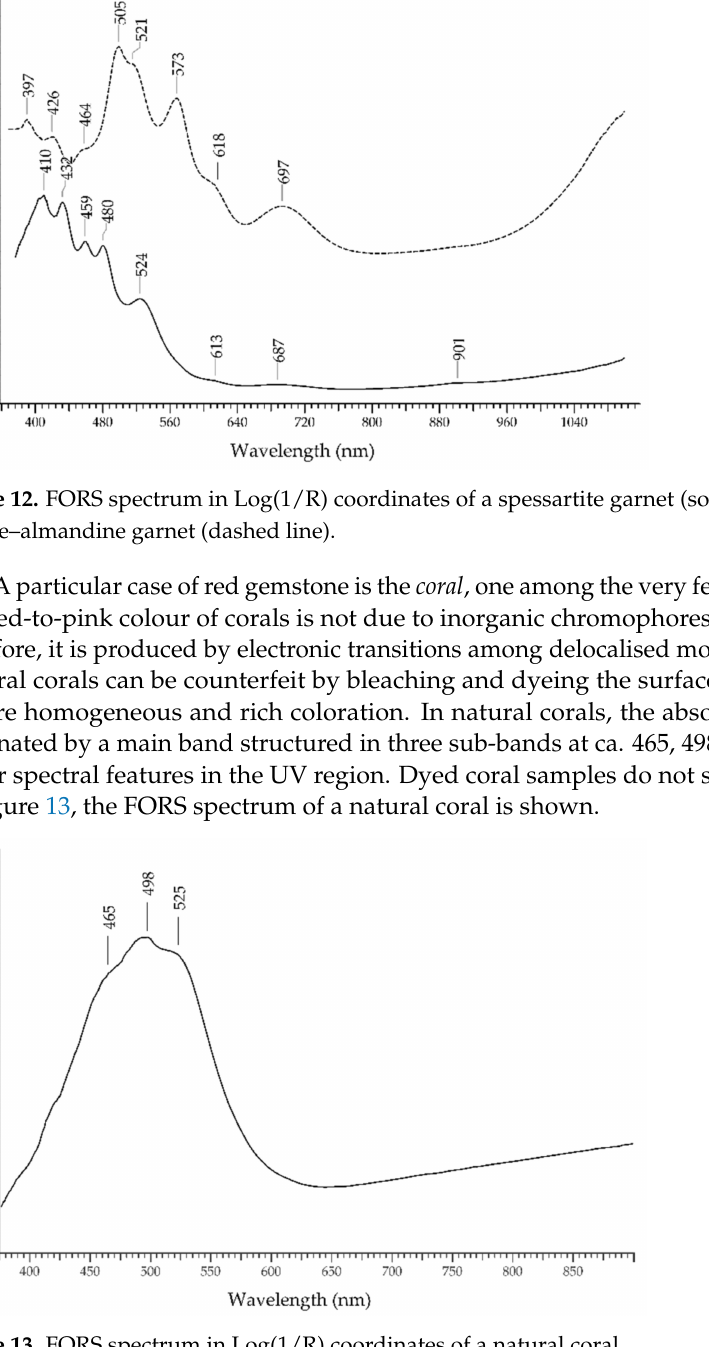
Figure 13. FORS spectrum in Log(1/R) coordinates of a natural